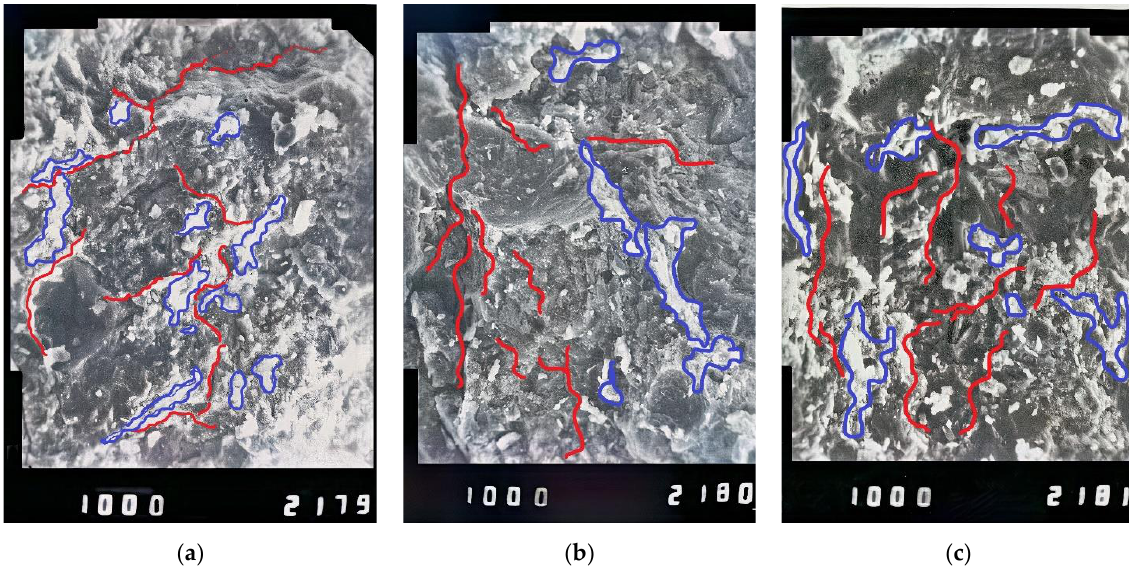
Figure 16. Microstructure of concrete after the action of sulfuric acid solution: ( a ) on the surface of the sample, ( b ) at a distance of 4 – 6 mm from the surface and ( c ) at a distance of 10 mm (cracks are marked with red, precipitates and ettringite crystals are marked with blue).